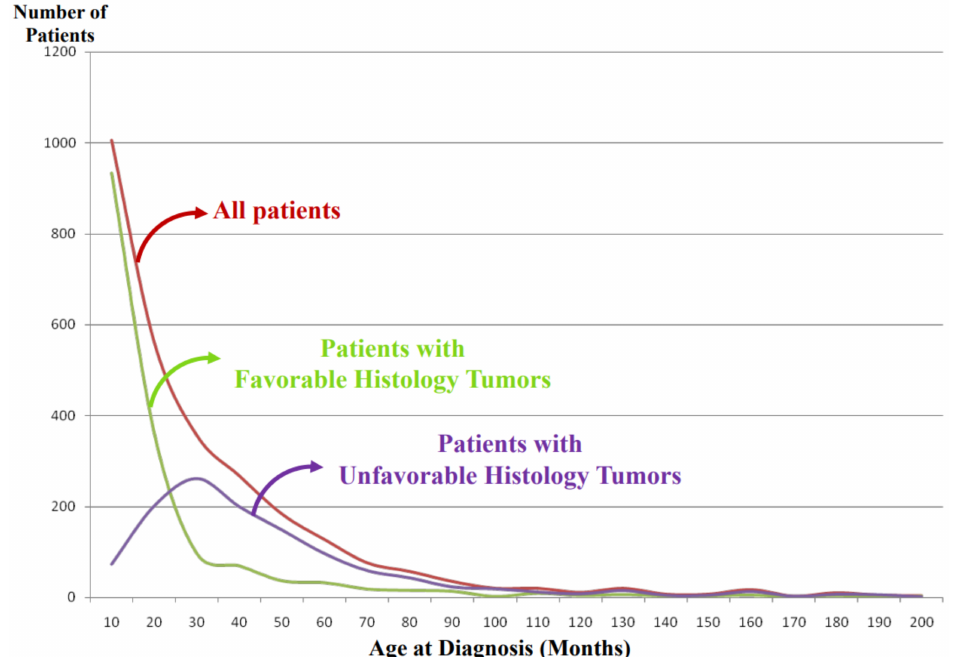
Figure 4. International Neuroblastoma Pathology Classification: patient distribution by age at diagnosis. Note: Most of the patients having favorable histology tumors are clinically detected and diagnosed in younger-age groups than the patients having unfavorable histology